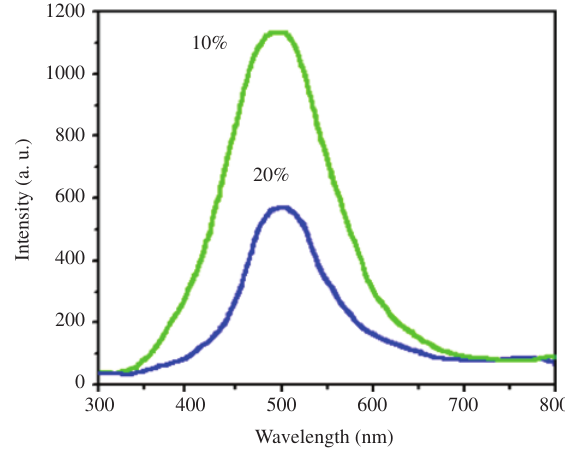
Figure 7: Electroluminescence spectra of prepared OLED devices with 10 and 20% (w/w) of complex 1 as the dopant.